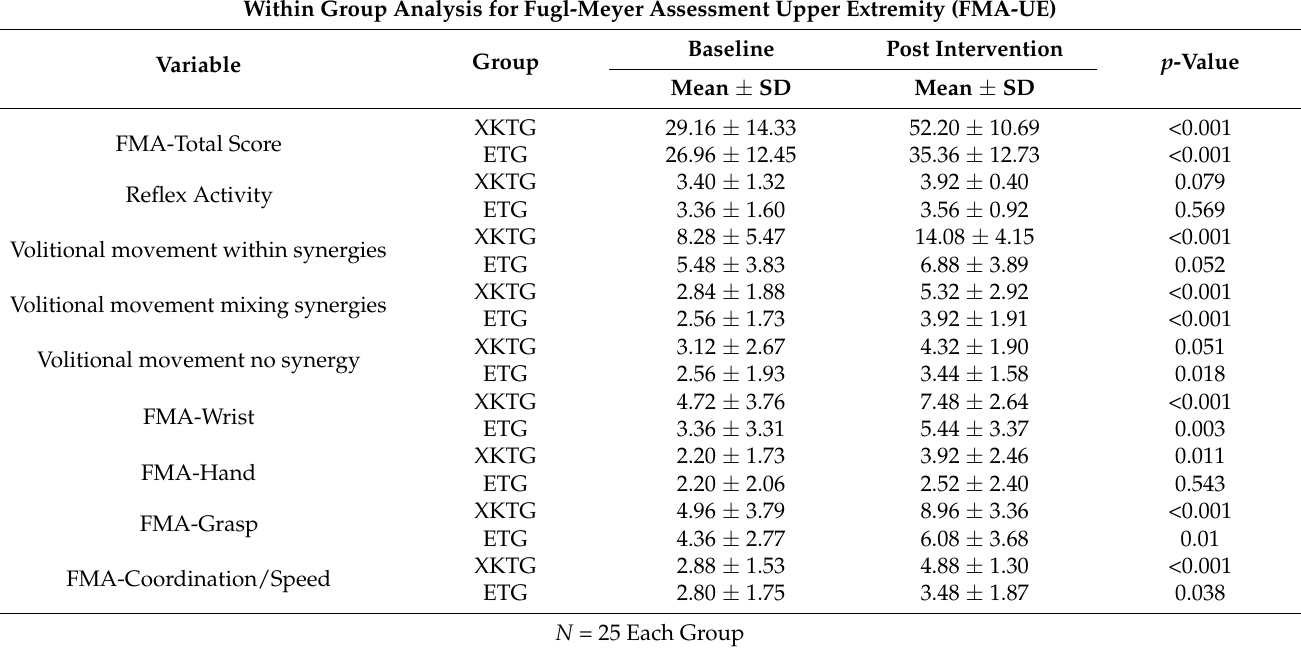
Table 3. Within group analysis for Fugl-Meyer Assessment Scale for Upper Extremity total score and each component. Within Group Analysis for Fugl-Meyer Assessment Upper Extremity (FMA-UE)